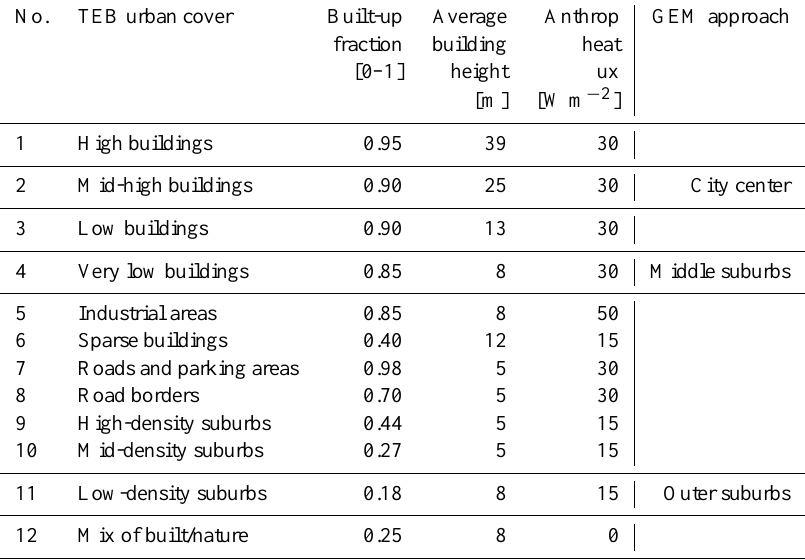
Table 1. Urban land-use categories in TEB – default settings for selected parameters in the GEM model.